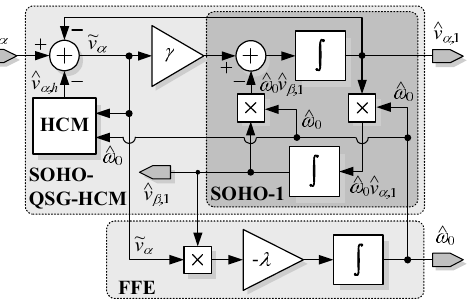
Figure 4. Block diagram of the proposed single-phase SOHO-based FLL scheme including a harmonic compensation mechanism